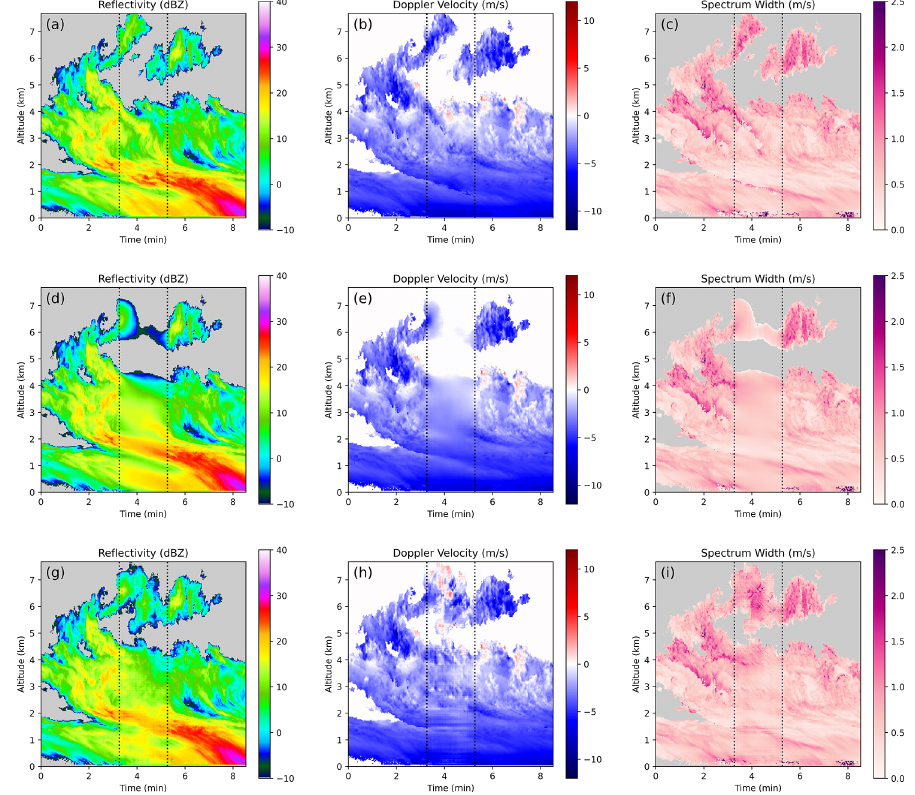
Figure 3. An example of inpainting a KaZR outage/missing data period. (a – c) Ground truth, (d – f) conventional CNN inpainting, and (g – i) CGAN inpainting.